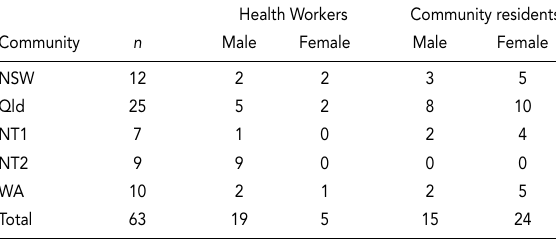
Number of Male and Female Respondents by Community, Learning Preference